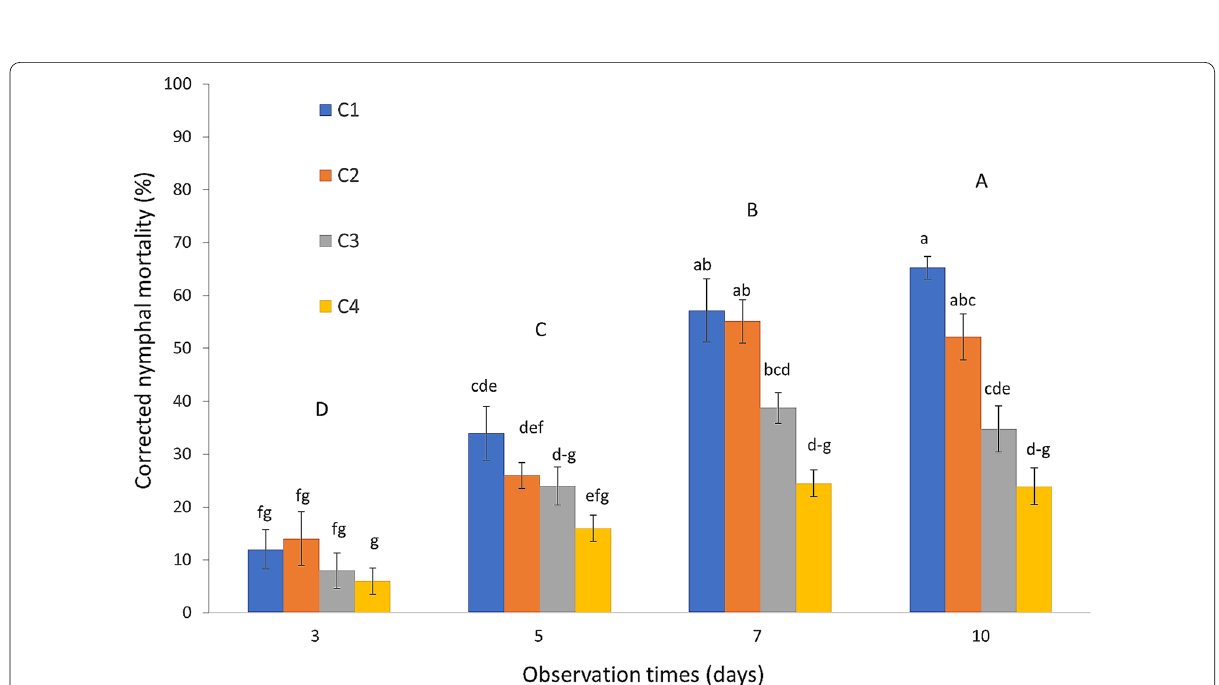
Fig. 2 Percent corrected mortality of late 3rd instar nymphs of peach-potato aphid Myzus persicae bioassayed against different concentrations of indigenously isolated strain of entomopathogenic fungus Metarhizium anisopliae under laboratory conditions. Concentrations C1–C4 correspond to 1.0 10 6 –1.0 10 9 conidia/ml. Small letters at bar tops indicate significant difference among the concentrations, while capital letters indicate × × overall significant difference among the mortality at different time intervals (factorial ANOVA followed by Tukey’s HSD test at α